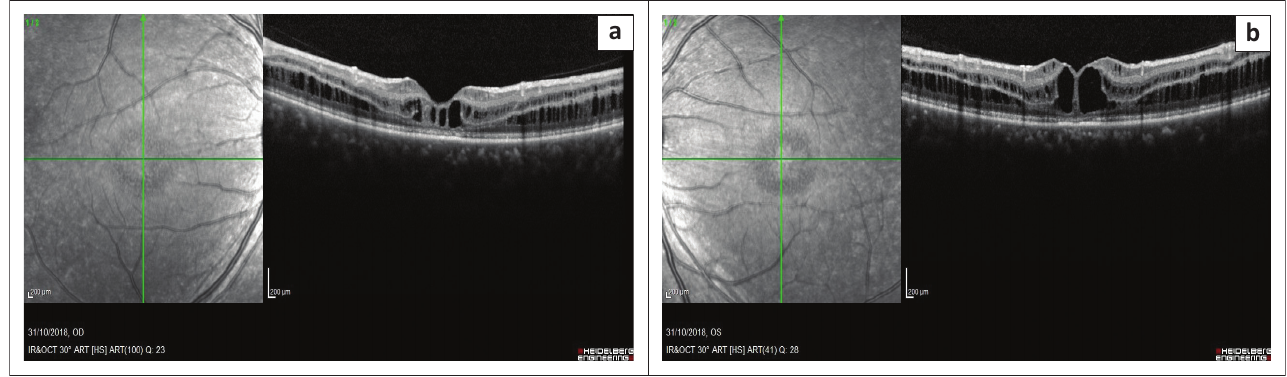
FIGURE 1: Spectral domain-optical coherence tomography of the right (a) and left eye (b) respectively. There are splitting/cystic changes in the inner nuclear layer (INL), the outer plexiform layer (OPL) and the outer nuclear layer (ONL). A finding consistent with XLRS cases in current literature (Schofield et al. 2016) 1 Our patient also presents with retinoschisis beyond the clinical impression and spoke-wheel pattern – a feature reported in other cases in the literature. 3